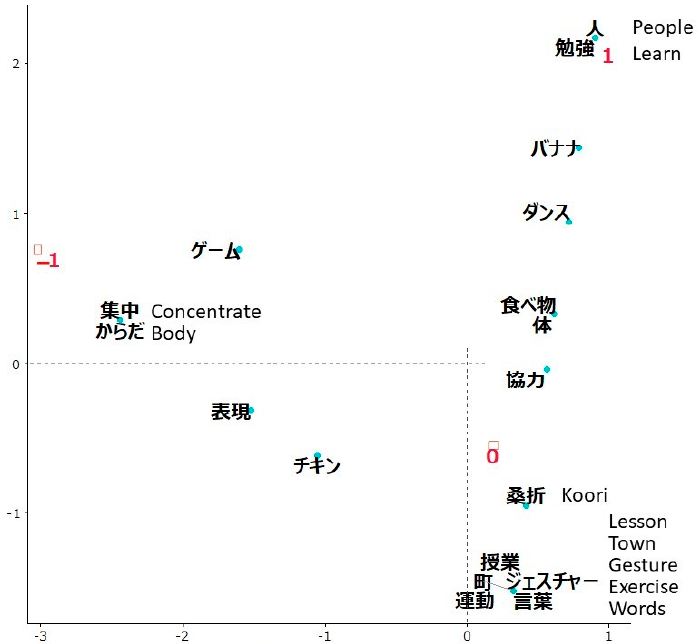
Figure 5. Correspondence analysis of words used in students’ opinions about the ACT workshop depending on changes in the evaluation indicator rating. The group with an increased rating of the workshop evaluation indicator was labeled as 1, no change in rating as 0, and a decreased rating as –1. Words that were not characteristic of any group were Banana (name of a song) , dance, game, food, body, collaborate, express, and Chicken (name of a